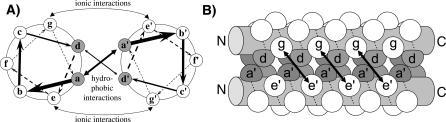
Schematic of a Parallel Dimeric Coiled Coil(A) Helical-wheel representation shows an end-on view of the structure. Opposing a and d residues interact in the core while opposing e and g residues frequently participate in electrostatic interactions.(B) Cartoon representation of the coiled coil, viewed from the side. Residues are represented as spheres. An e position is better located for interaction with the g position of the previous heptad on the opposing strand than with the g position of the next heptad (bold arrows). This interaction is denoted g-e′+, and coupling energies for it have been determined experimentally [24].